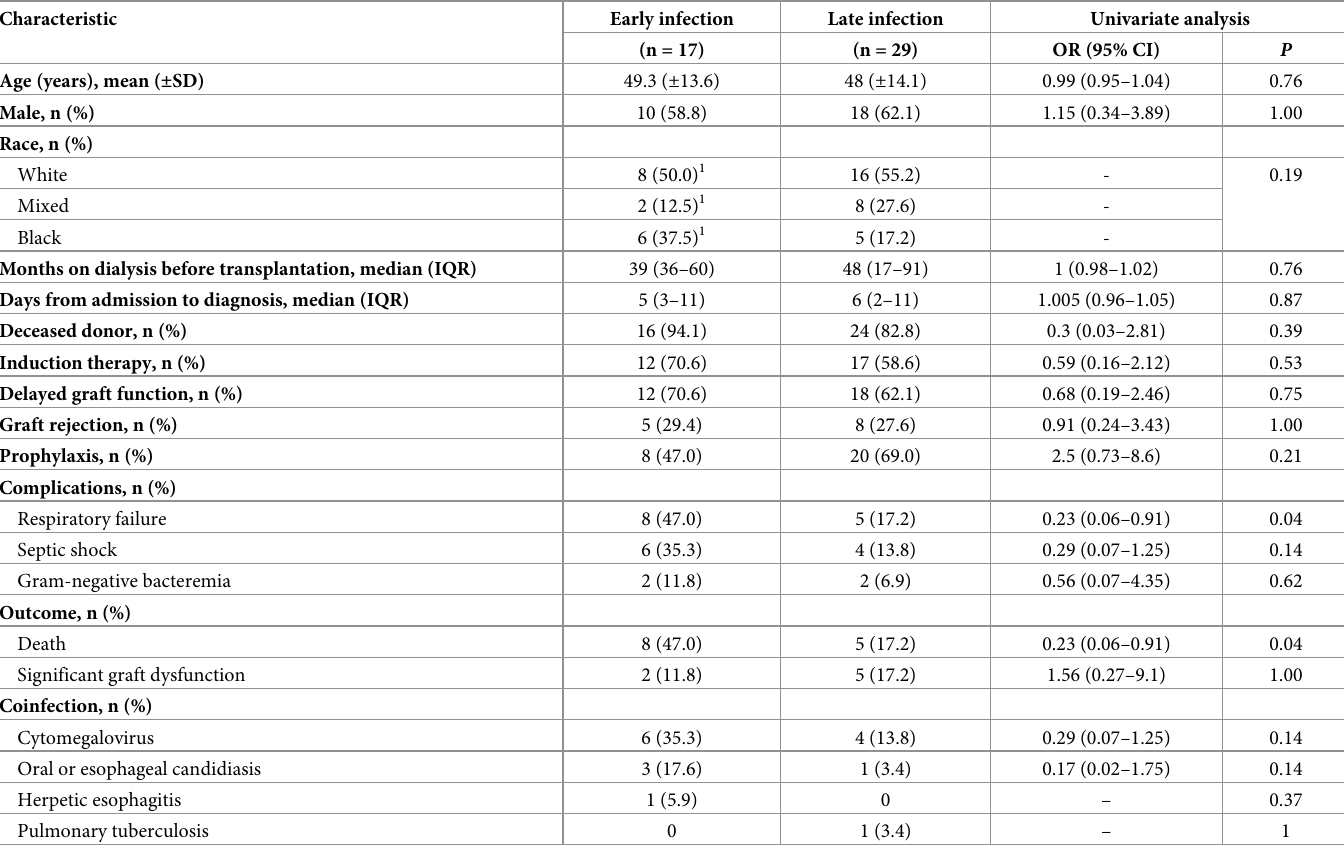
Table 4. Comparison and univariate analysis of early and late severe Strongyloides stercoralis infection, by clinical and demographic